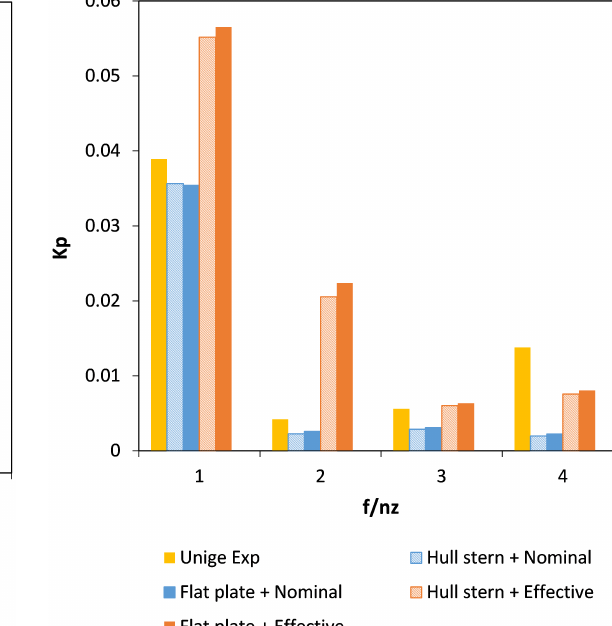
Figure 13: Pressure pulses in correspondence to the cavitation tun- nel measuring point. Effect of hull shape and inflow